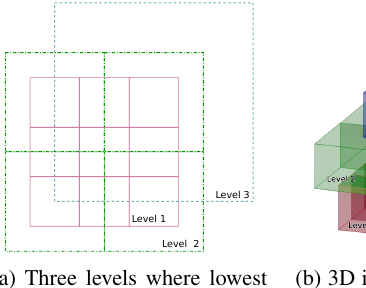
Figure 1: Pseudo code as given by van Oosterom and Vijlbrief (1996) for determining the layout of a Fieldtree (its grid size and the shifted origin of the grid cells at every level). Note that the number of levels (needed to be able to fit the whole domain of the dataset in one last field) can be determined given the parameter for the finest grid size (finegrid) and the extent of the dataset.